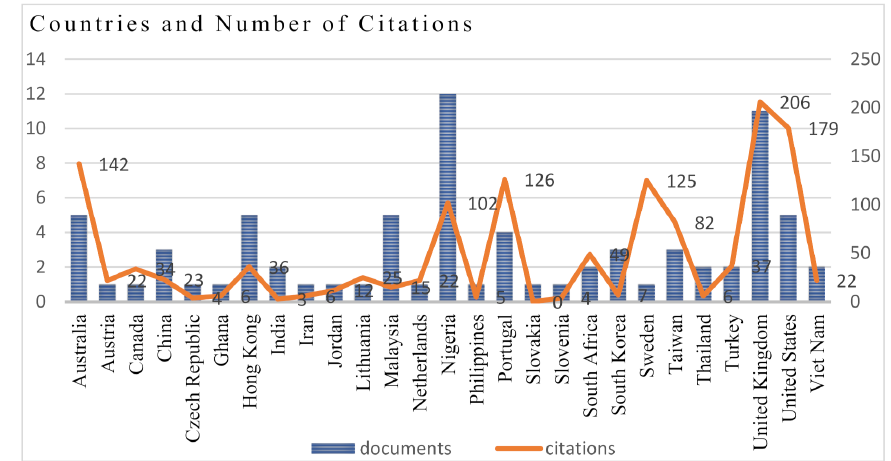
Figure 5. Manuscripts distributions per countries; Source: authors’ computation. Note: Left Y- axis shows publication number per countries; right Y-axis shows publication number citations per